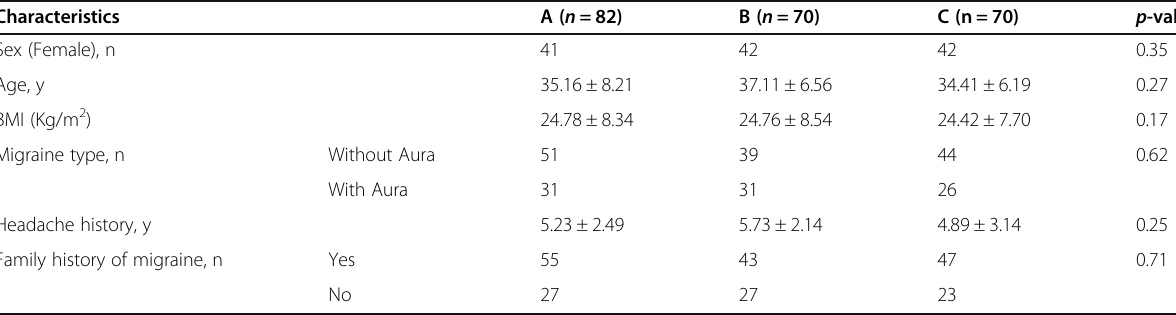
Table 1 Patient Demographic characteristics at baseline